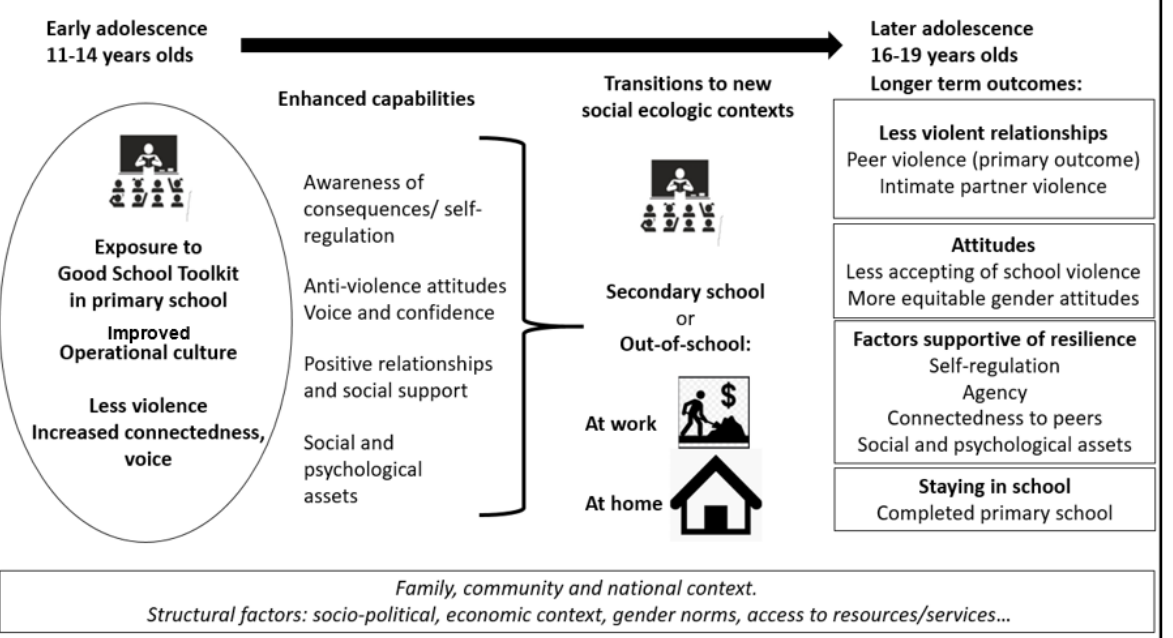
Figure 2. Schematic illustrating the toolkit intervention long-term effects conceptual